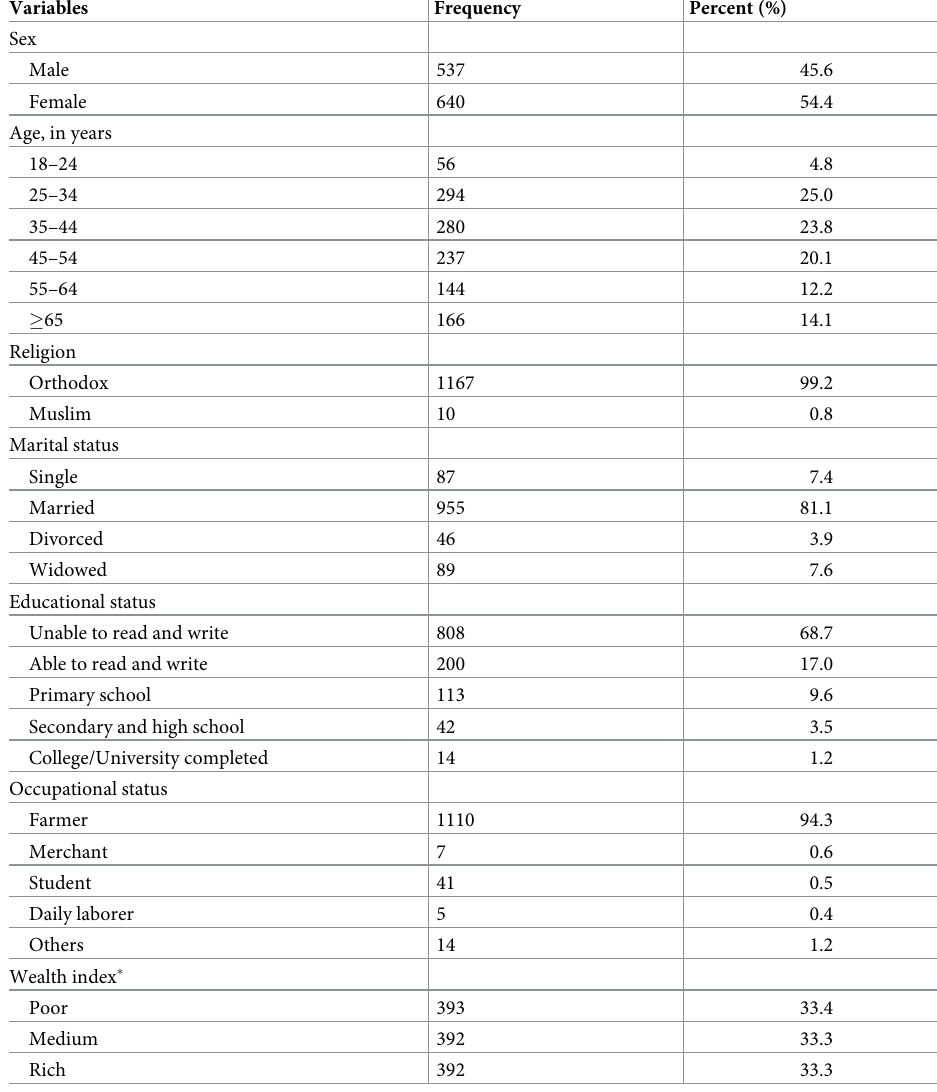
Table 1. Sociodemographic characteristics of participants in northwest Ethiopia, June-October 2020.